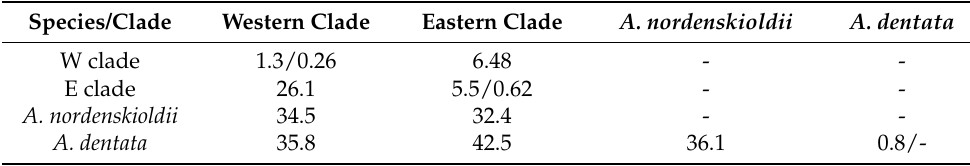
Figure 1. Maximum likelihood phylogenetic trees based on sequences of the mitochondrial cytochrome oxidase subunit I (COI) mtDNA gene ( a ) and the nuclear ITS1-5.8SrRNA-ITS2 region ( b ) of Attheyella crassa . Numbers at the nodes are bootstrap values. As an outgroup, sequences of Elaphoidella bidens (accession numbers MW851202-MW851206) for COI gene tree and Tigriopus californicus (KF851276) for ITS gene tree were used. The bars between the trees indicate the “species” identified by different species delimitation methods for each gene (ABGD, GMYC, PTP) and for both genes together (STACEY). Median joining networks of ( c ) COI and ( d ) ITS haplotypes from A. crassa . Black dots indicate median vectors (ancestral, unsampled, or extinct haplotypes). Black hatch marks denote the number of mutational steps between haplotypes. Circles are proportional to the haplotype frequency. Table 2. Average model-corrected genetic distances (%) between two main clades (E and W) of Attheyella crassa and between them and other Attheyella species: below diagonal—COI, above diagonal—ITS, in the diagonal values within